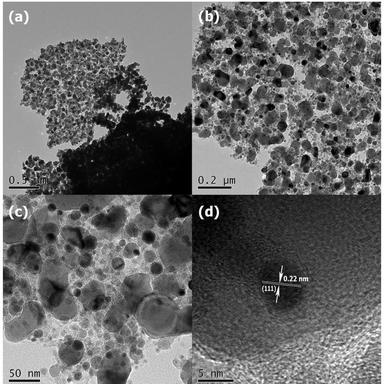
(a, b, c) Illustrate the TEM images and (d) HRTEM image of as prepared Ni-NSAs.